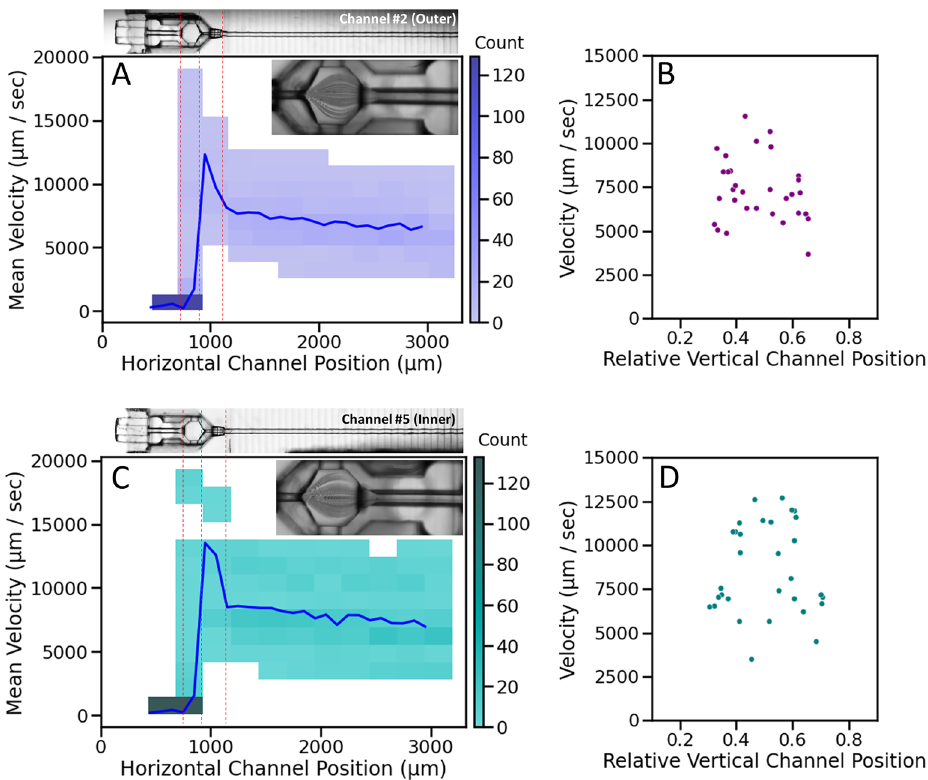
Figure 4. 2D histograms of bead velocity per channel length, for the second-to-outermost channel #2 ( A ) and innermost channel #5 ( C ). The blue trace is the mean velocity profile, with the corresponding projection of bead tracks (inset). Velocity profiles are shown within the channel for channel #2 ( B ) and #5 ( D ), relative to the channel walls.